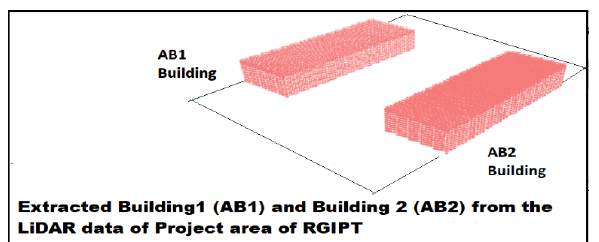
Figure 3. The subtracted output to calculate height-based point After extracting the elevated features out from the LiDAR